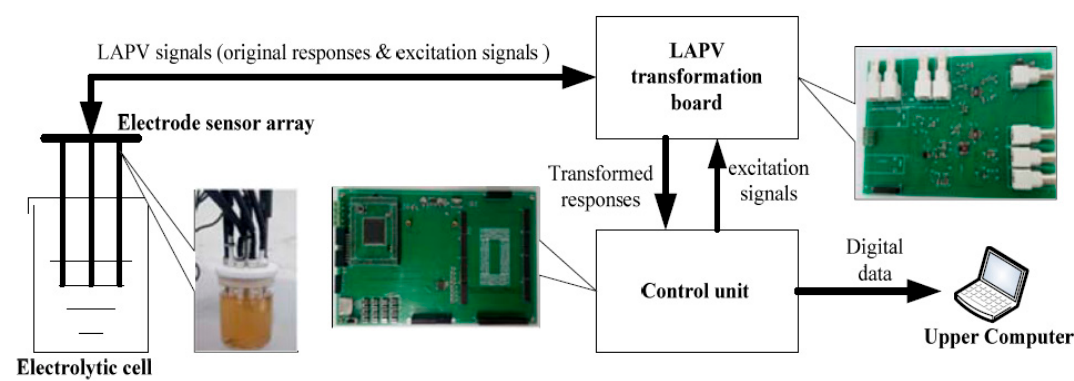
Figure 1. Structure of developed large amplitude pulse voltammetry (LAPV) electronic tongue (E-